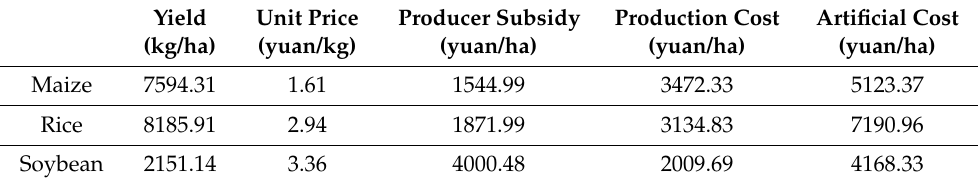
Table 7. Economic statistics for major crops in Jilin Province in